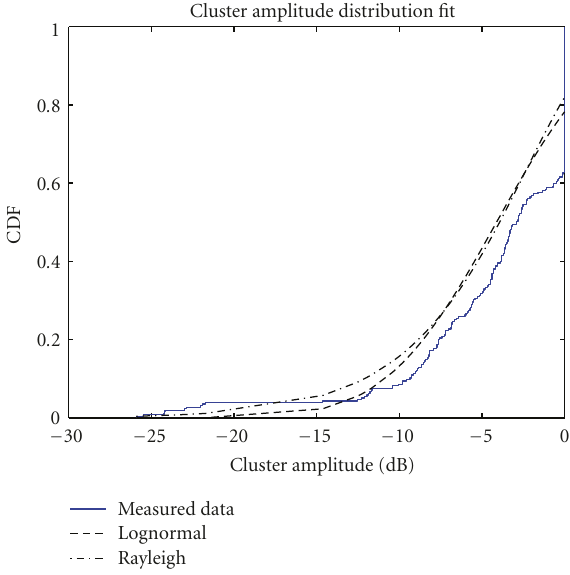
Figure 19: Cluster amplitudes CDF with the best-fit Rayleigh (RMSE = 0.0891) and lognormal (RMSE = 0.0884) distributions for measurements inside the Escalade engine